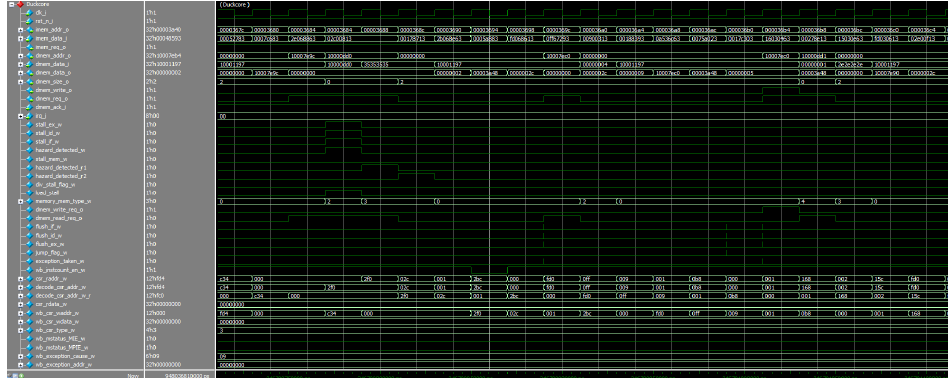
Figure 29. CoreMark operation waveform.